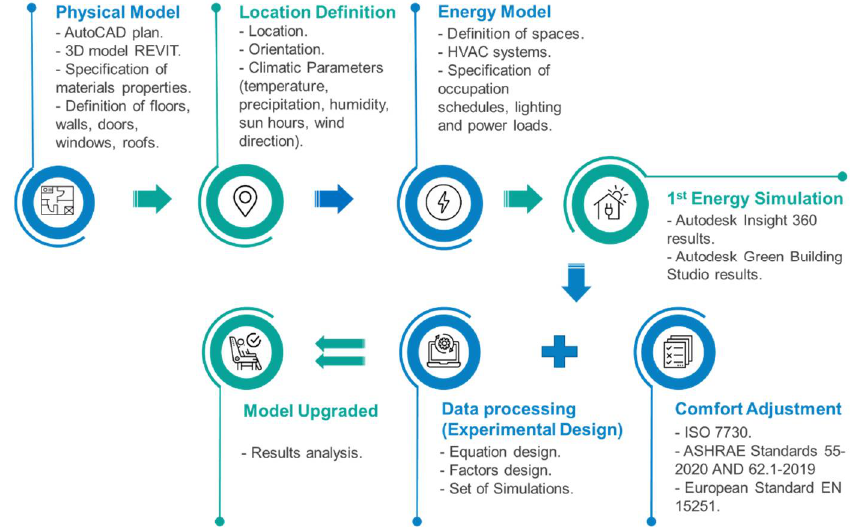
Figure 1. Methodology flowchart.